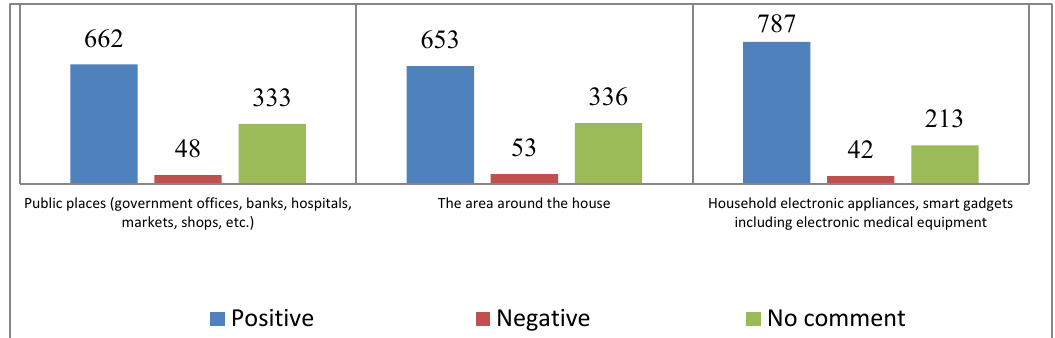
Figure 4. The elderly’s attitude toward the digital environment’s impact on life (N=1043).